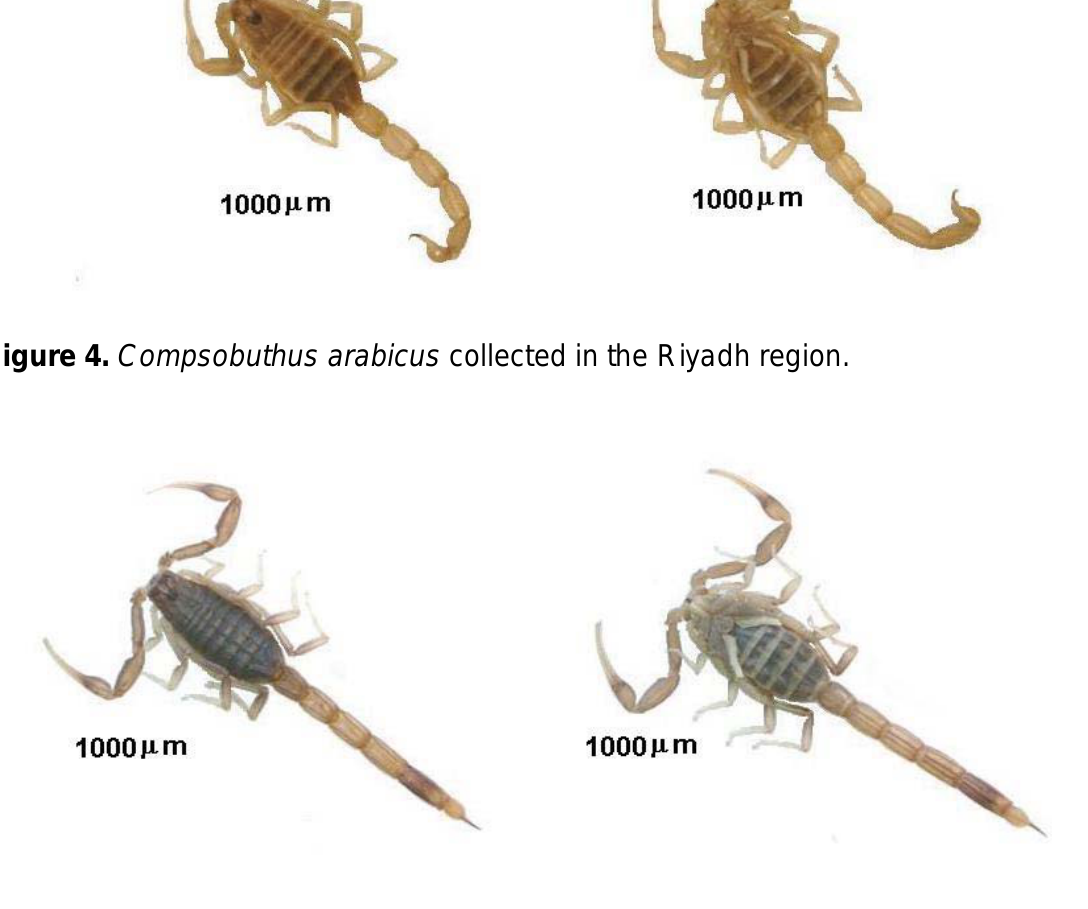
Figure 5. Compsobuthus werneri collected in the Riyadh region.